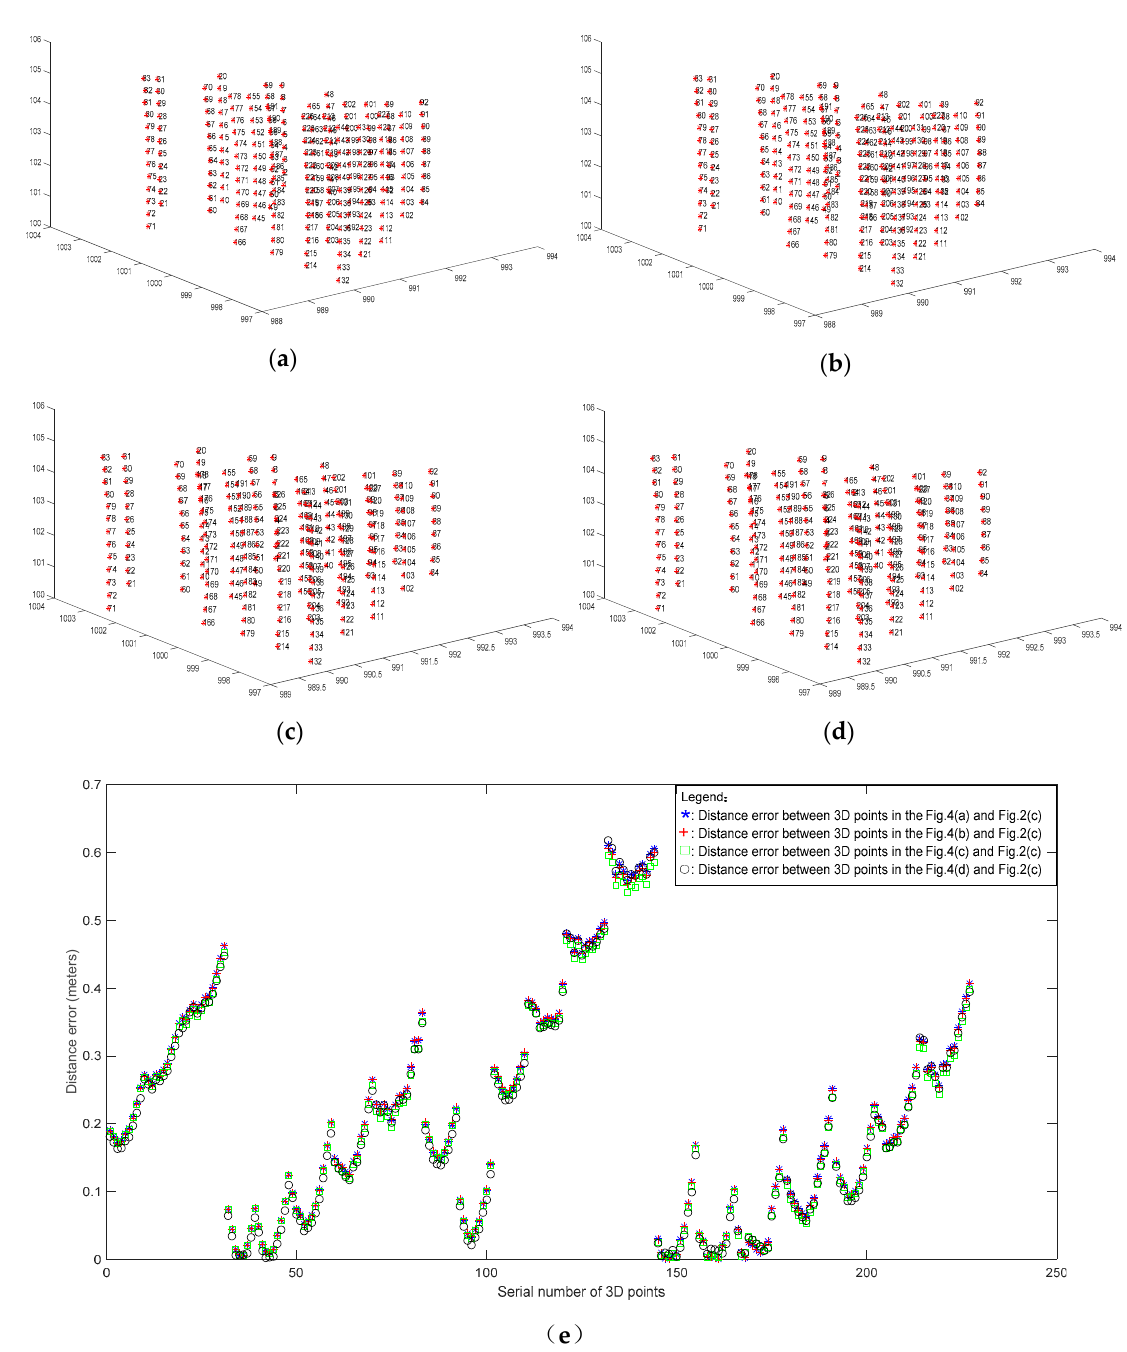
Figure 4. 3D points and their distance errors. 3D points calculated on the basis of the matching points in ( a ) Figure 3(a1), ( b ) Figure 3(b1), ( c ) Figure 3(c1), and ( d ) Figure 3(d1). ( e ) Distance errors of 3D points between the calculated and true values.